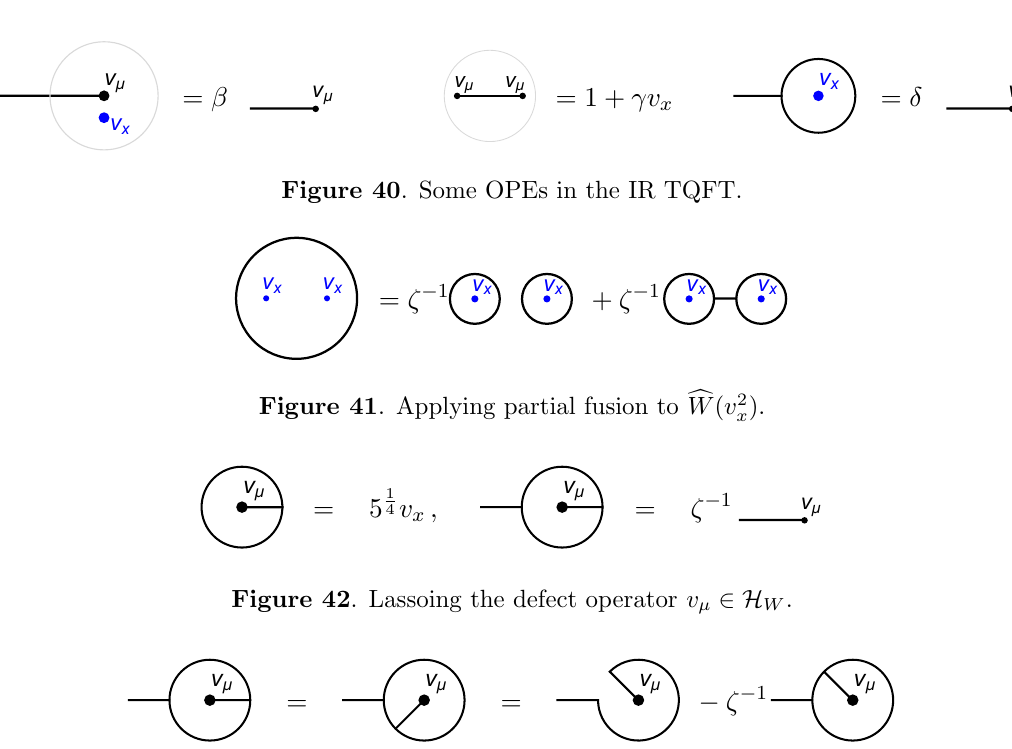
Figure 42 . Lassoing the defect operator v (cid:22) 2 H W .